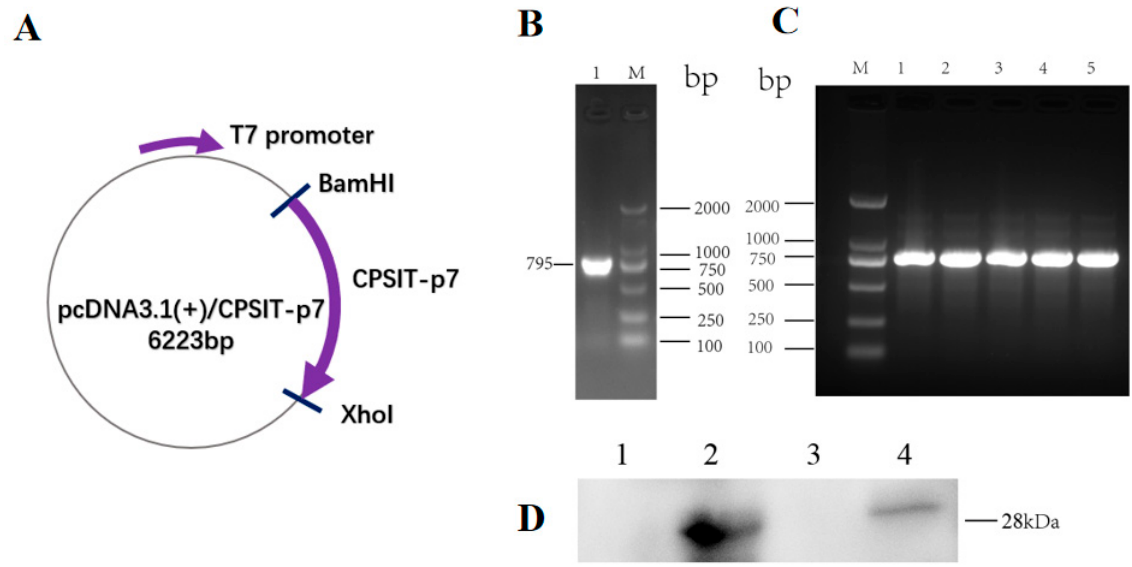
Figure 1. Diagram showing pcDNA3.1(+)/CPSIT_p7 plasmid structure and identification of the construction and function via PCR amplification and Western blot. ( A ) The structure diagram of pcDNA3.1(+)/CPSIT_p7 plasmid. ( B ) PCR amplification of CPSIT_p7 gene. The CPSIT_p7 gene (795bp) and the 2000 bp DNA ladder were visualized in lanes one and M, respectively. ( C ) Bacteria PCR amplification of pcDNA3.1(+)/CPSIT_p7. The 2000 bp DNA ladder was loaded in lane M, and the pcDNA3.1(+)/CPSIT_p7 DNA fragments (795bp) were seen in lanes one to five. ( D ) Western blot analysis showing the expression of CPSIT_p7 protein in HeLa cells. Plasmid pcDNA3.1(+)/CPSIT_p7 was transfected into HeLa cells using lipofectamine 3000. After 48 h, these cells were lysed and immunoreacted with a rabbit anti- C. psittaci antibody. Lane one, untransfected HeLa cells (PBS); lane two, recombinant protein CPSIT_p7; lane three, HeLa cells transfected with empty pcDNA3.1(+) vector; lane four, HeLa cells transfected with pcDNA3.1(+)/CPSIT_p7 plasmid.